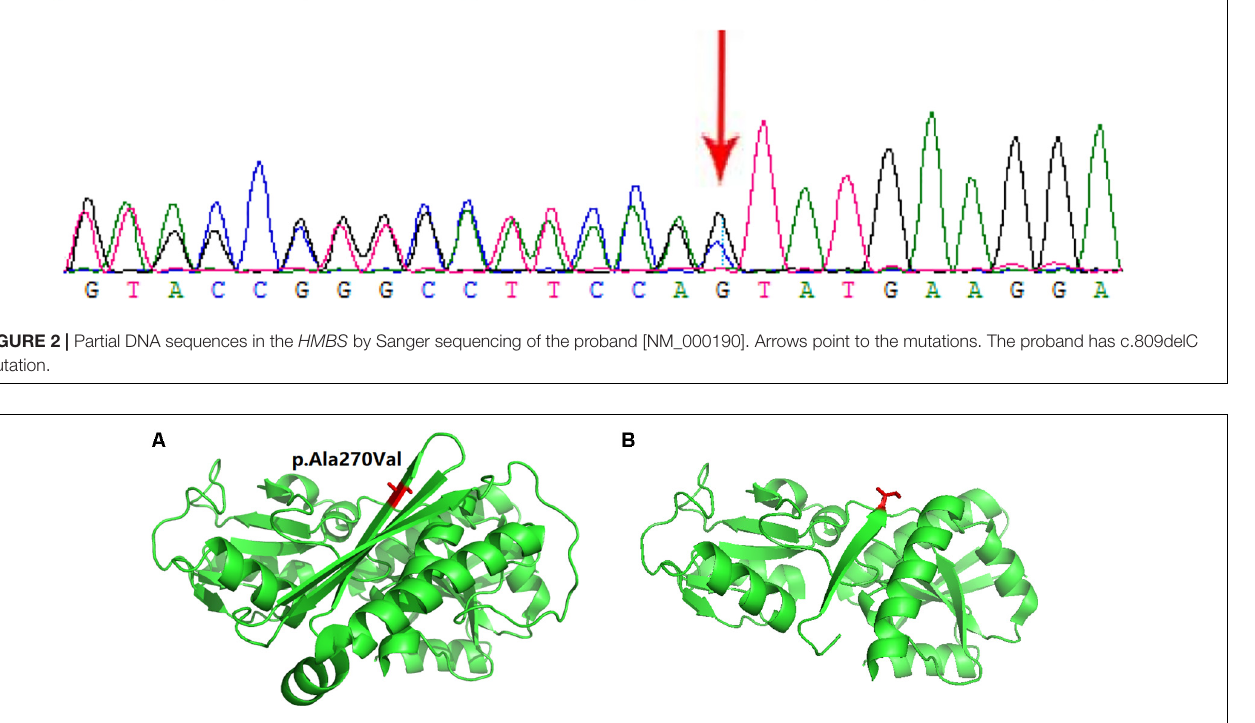
FIGURE 3 | Schematic presentation of Protein 3D model. (A) The location (in “Red” color) of the mutation in the wild type protein. (B) The structure of the mutant protein upon frameshift